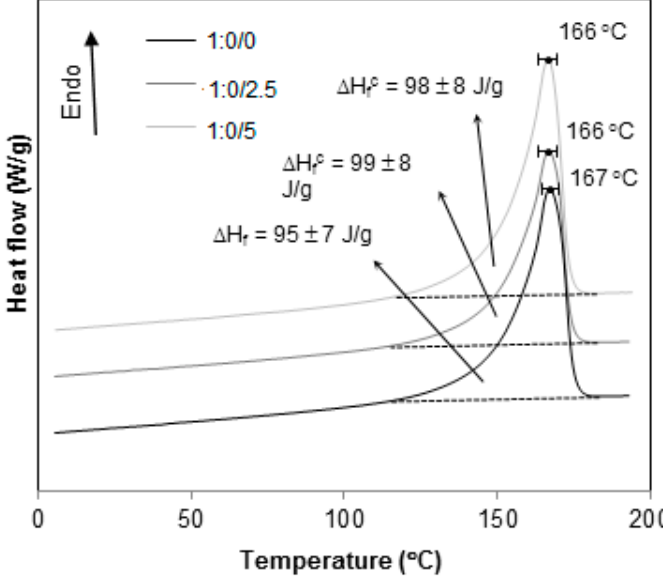
Figure 14. DSC thermograms of PP with 0, 2.5 and 5 phr of CNSL.